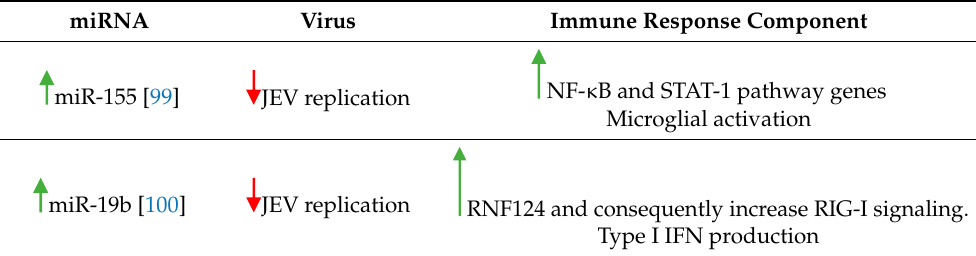
Table 1. miRNAs and neurodevelopment. Table 3. miRNAs that increase immune response.